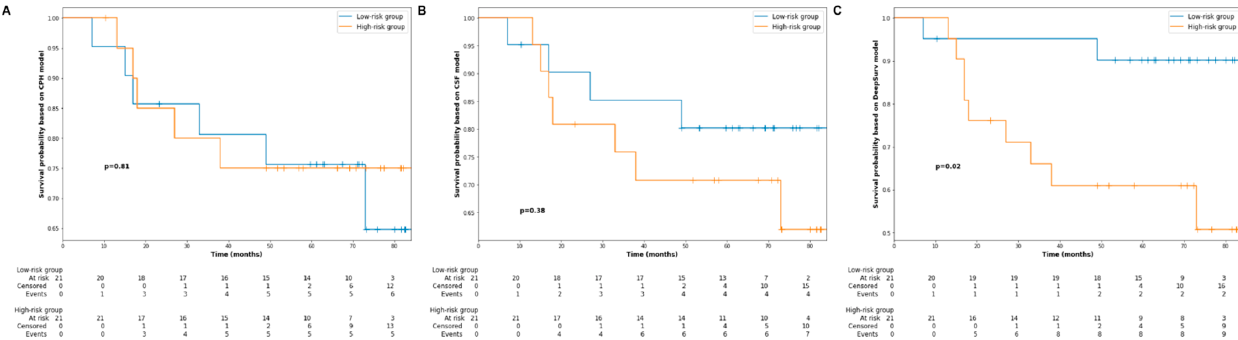
Figure 5. Kaplan–Meier curve estimates of progression-free survival for the testing cohort stratified into low- and high- risk groups depending on the median risk value output by the three models (( A ) Cox proportional hazards model, ( B ) conditional survival forest, ( C ) DeepSurv).